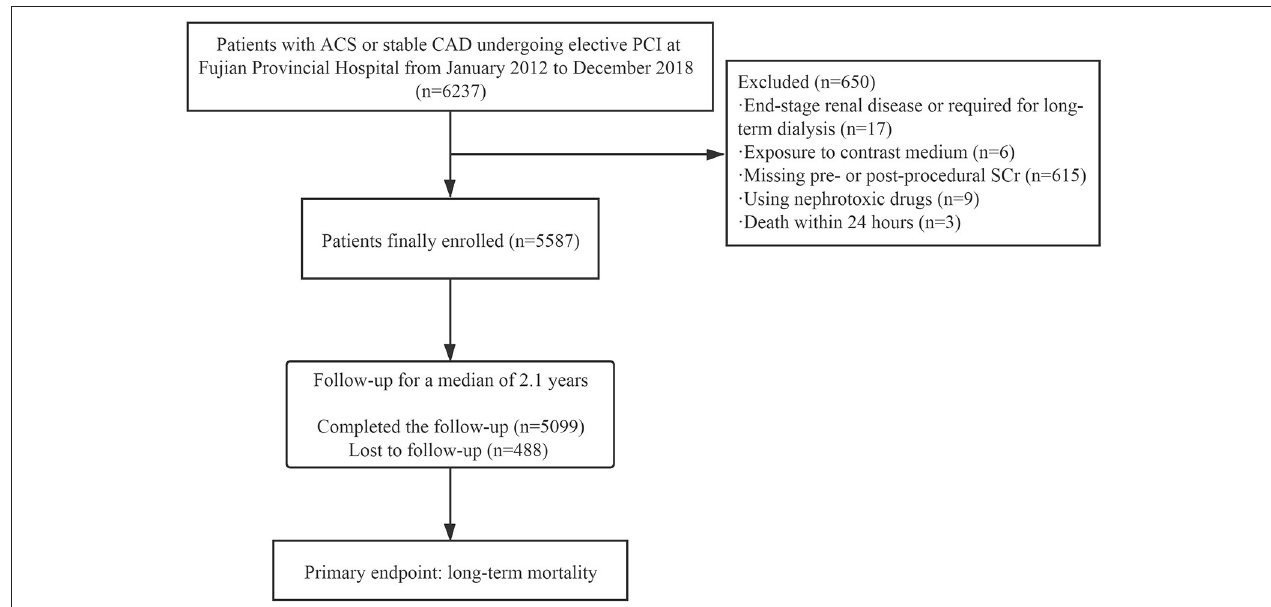
FIGURE 1 | Flowchart showing the procedure used for patient recruitment. ACS, acute coronary syndrome; CAD, coronary artery disease; PCI, percutaneous coronary intervention; SCr, serum